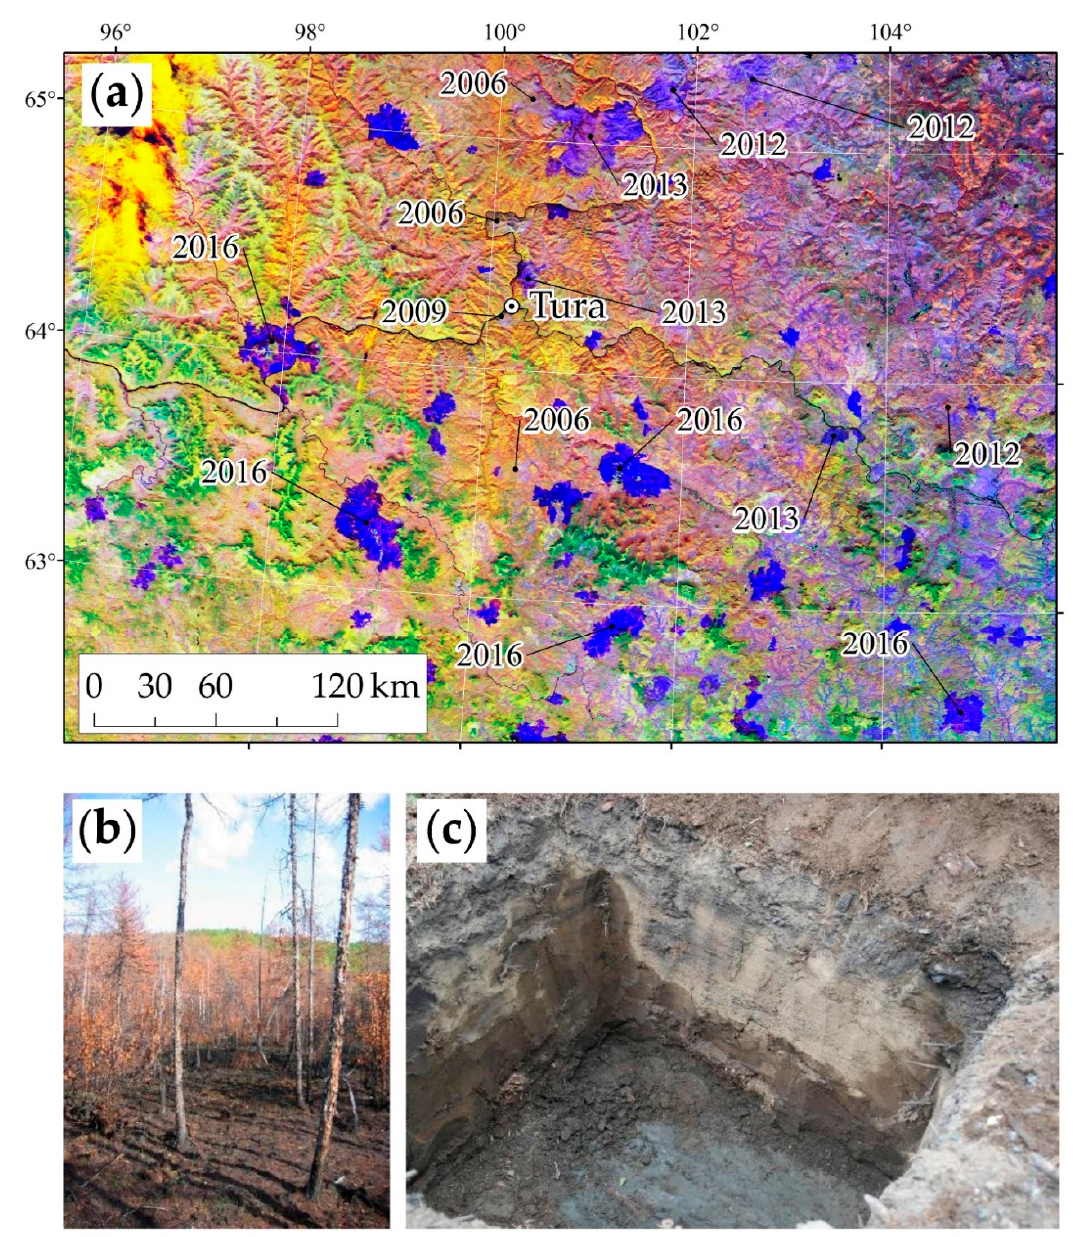
Figure 2. Post-fire disturbances and changes of surface cover: fire-damaged territories on a Terra / MODIS satellite image. Combination of #1, #2 and #31 (thermal) bands, blue polygons are large-scale post-fire plots of different succession stages, marked with the year of burning ( а ); a disturbed surface layer of a 1-year-old post-fire plot ( b ); and a non-disturbed soil profile with permafrost at a depth of 1 m ( c ). Field data from the Evenkia region. Photo by O. Masyagina. For the selected post-fire plots, we collected datasets on the temperature of the surface and NDVI years. Next, data for post-fire plots that were 1, 2, 5 and 10 years old were compared with values from the nearest non-disturbed areas, which were used as controls. We used the deviation (in percentage) of the temperature and NDVI values for the post-fire plots relative to the control plots’ values as a measure of fire-caused anomalies. Finally, according to satellite data pre-processing, we quantified the changes in NDVI and thermal characteristics, and we also estimated the time lag and restoration rate of the NDVI and surface temperature after a fire disturbance. However, we did not calculate the broadband albedo and the emissivity coefficient, since a limited set of spectral channels was used.